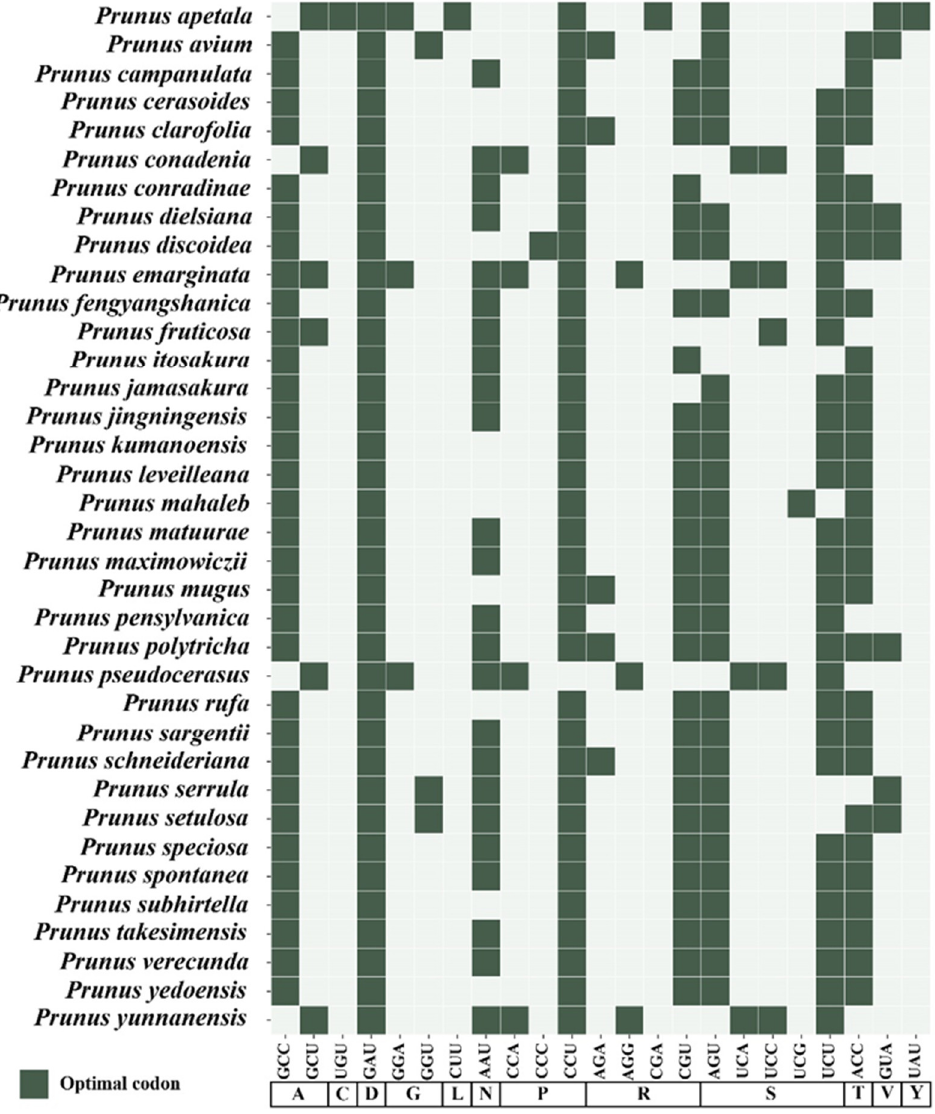
Figure 6. Optimal codon analysis of 36 subg. Cerasus species. The x-axis indicates the optimal codon and its corresponding encoded protein, and the y-axis represents the 36 subg. Cerasus accessions. Dark block positions indicate optimal codons in each species.